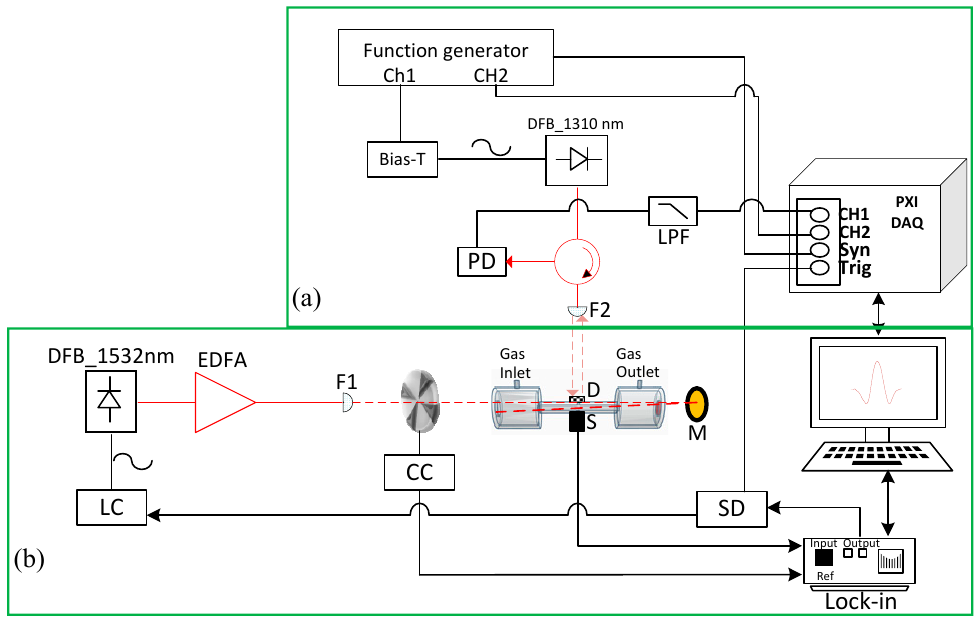
Figure 3. Experimental measurement setup: ( a ) PGC interferometer. DFB_1310 nm, DFB laser at 1310 nm; PD, photodetector; LPF, low pass filter; DAQ, data acquisition; and F1, F2 collimators. ( b ) Photoacoustic system. DFB_1532 nm, DFB laser at 1532 nm; LC, laser controller; EDFA, erbium-doped fibre amplifier; CC, chopper controller; D, diaphragm; S, microphone; M, mirror; SD, signal divider; Lock-in amplifier.